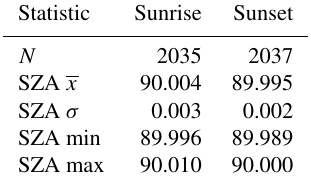
Table 4. Solar zenith angle statistics from all (4072) SAGE-III over- passes between 16 March and 12 August 2017. Solar zenith angles were calculated with respect to a surface instrument’s viewing ge- ometry based on the SAGE-III observation time and surface latitude and longitude. Statistic